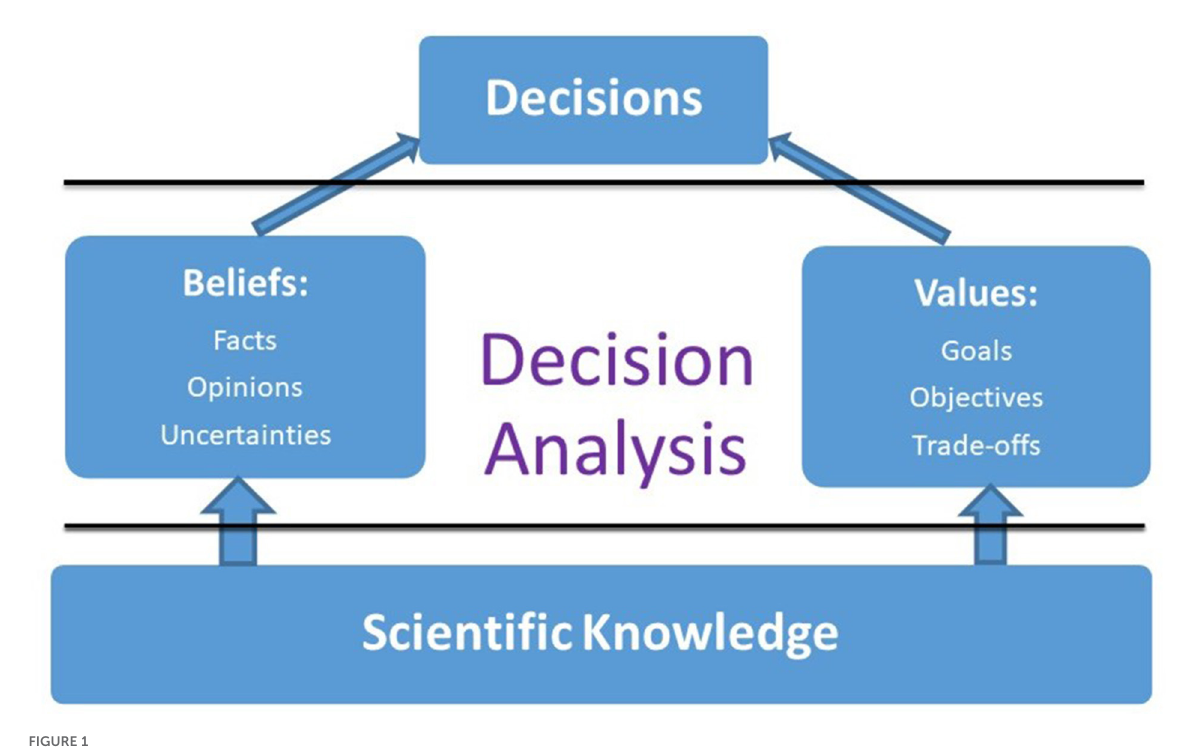
FIGURE1 Framework to bridge science and decision making; Winterfeldt (20) (reproduced with